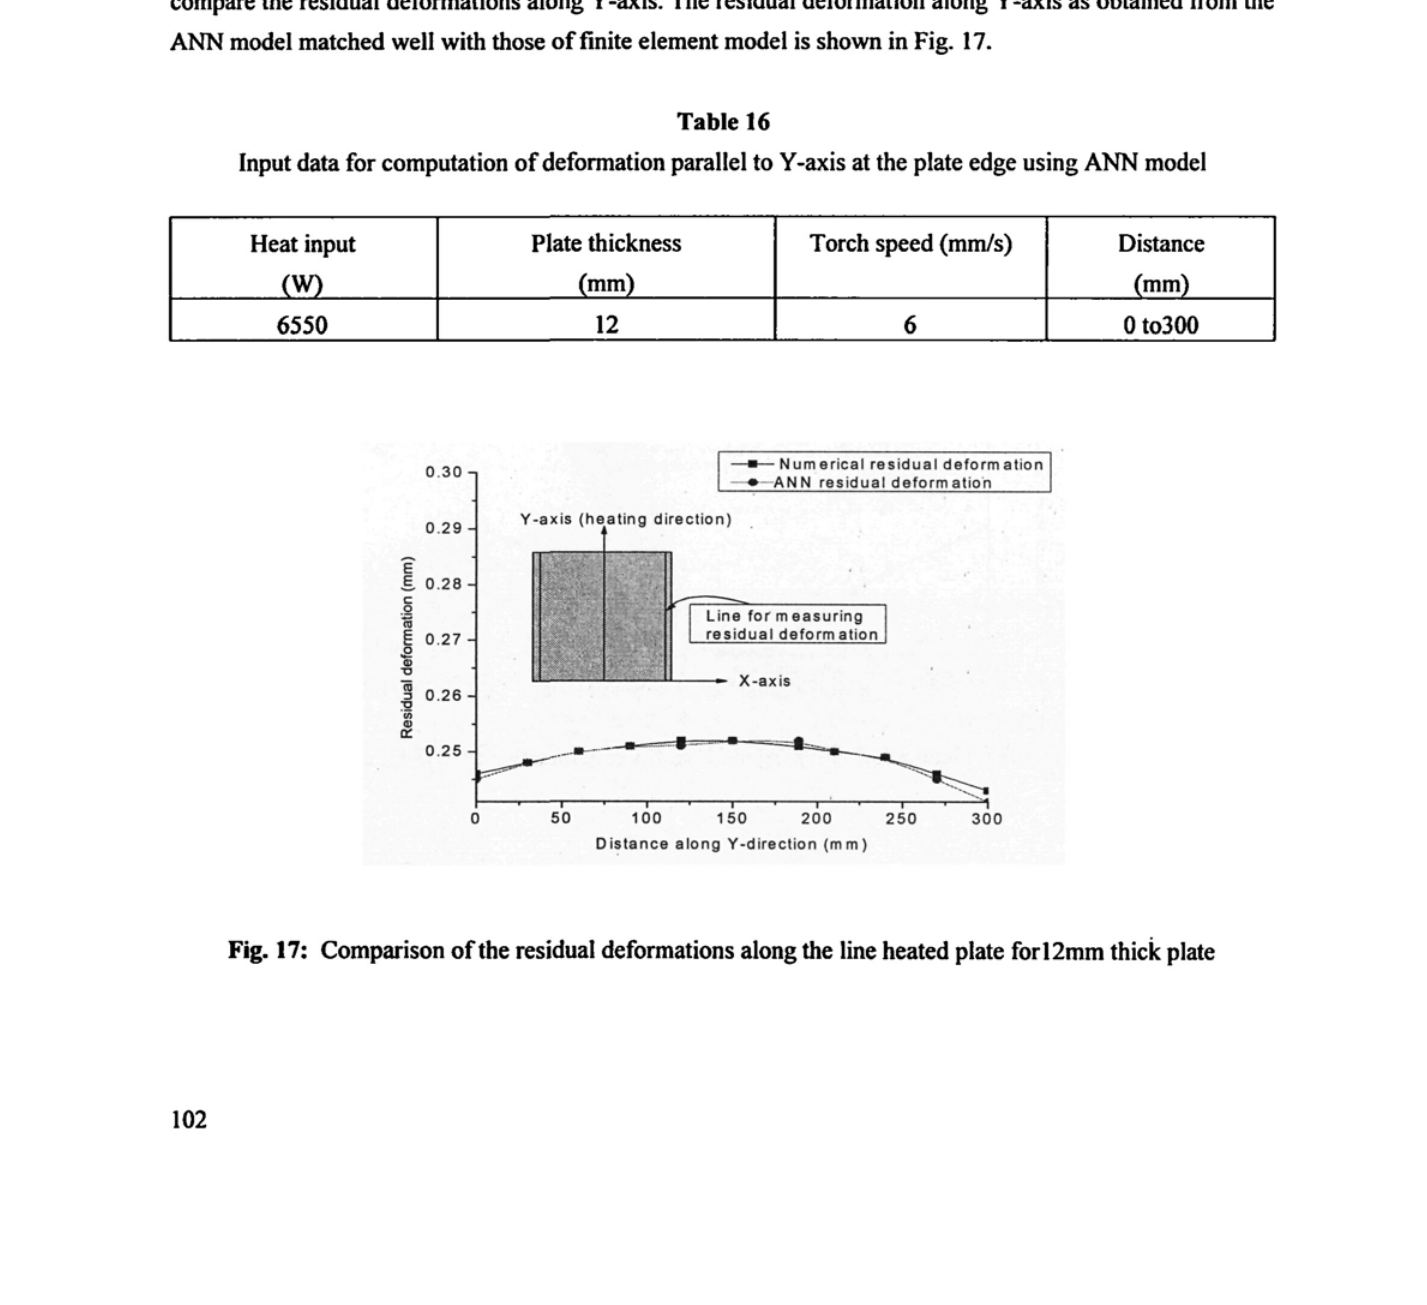
Input data for computation of deformation parallel to Y-axis at the plate edge using ANN model